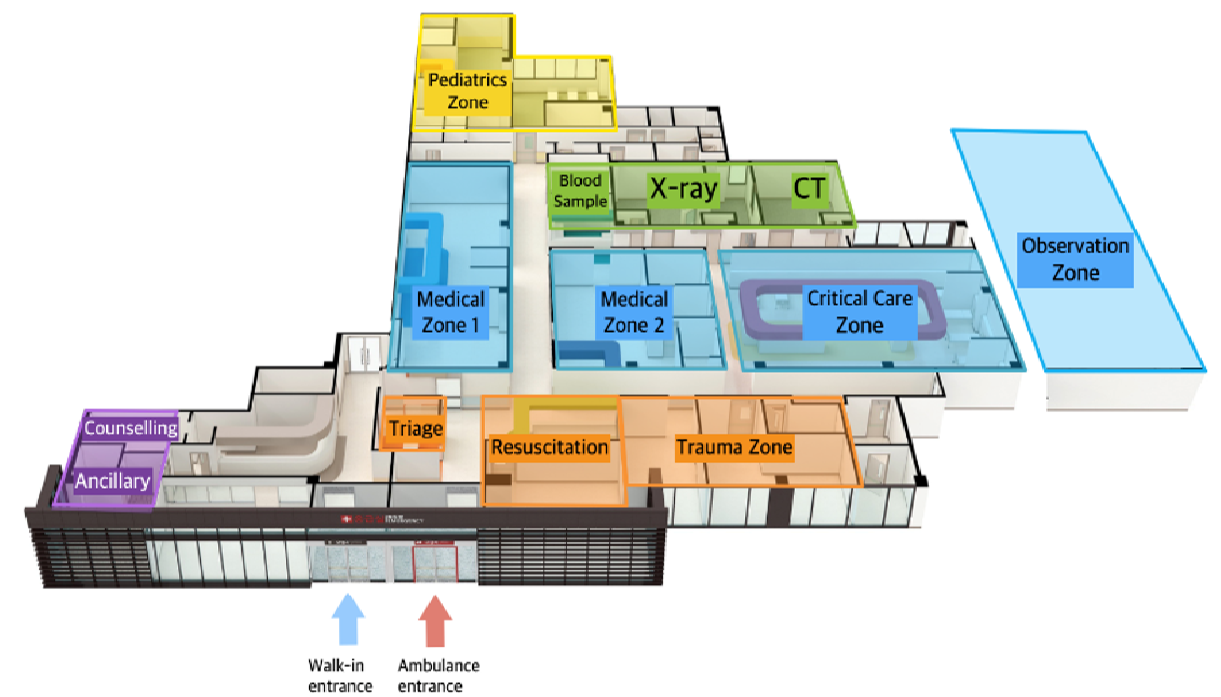
Figure 1. Geographical layout of the emergency